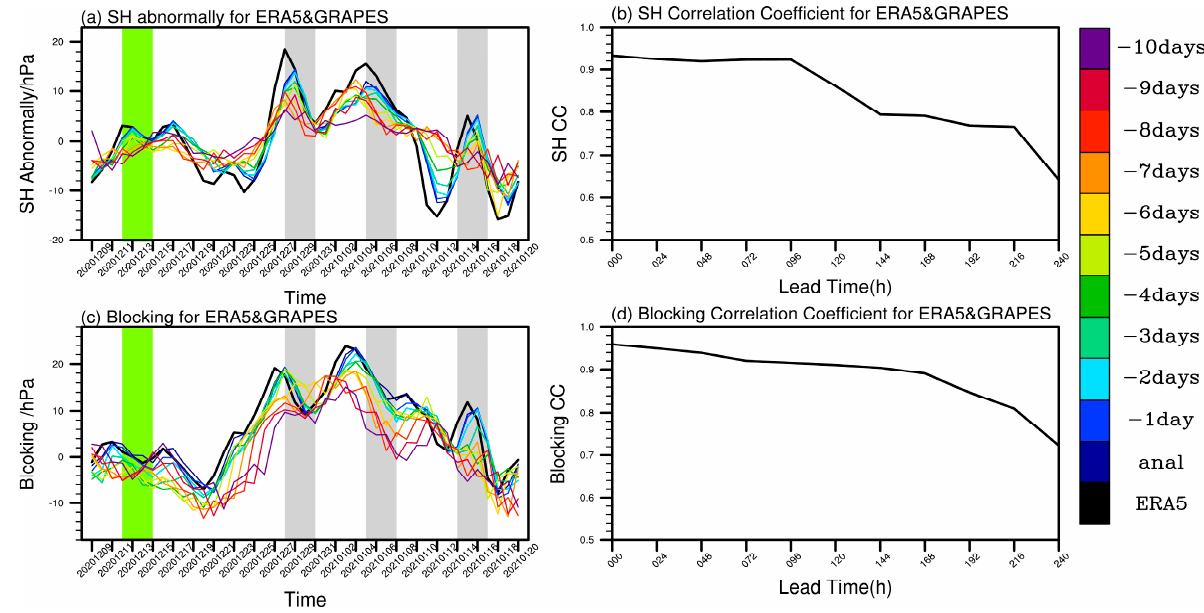
Figure 9. ( a ) Anomalies of Siberian high intensity index in CMA-GEPS system and observation and ( b ) correlation coefficients between model and observation during the 2020/2021 cold wave. ( c , d ) are similar to ( a , b ) but are blocking high intensity index. The green fill in the figure represents the “1212” event. The gray fi ll in the fi gure represents the timing of the three cold wave events.